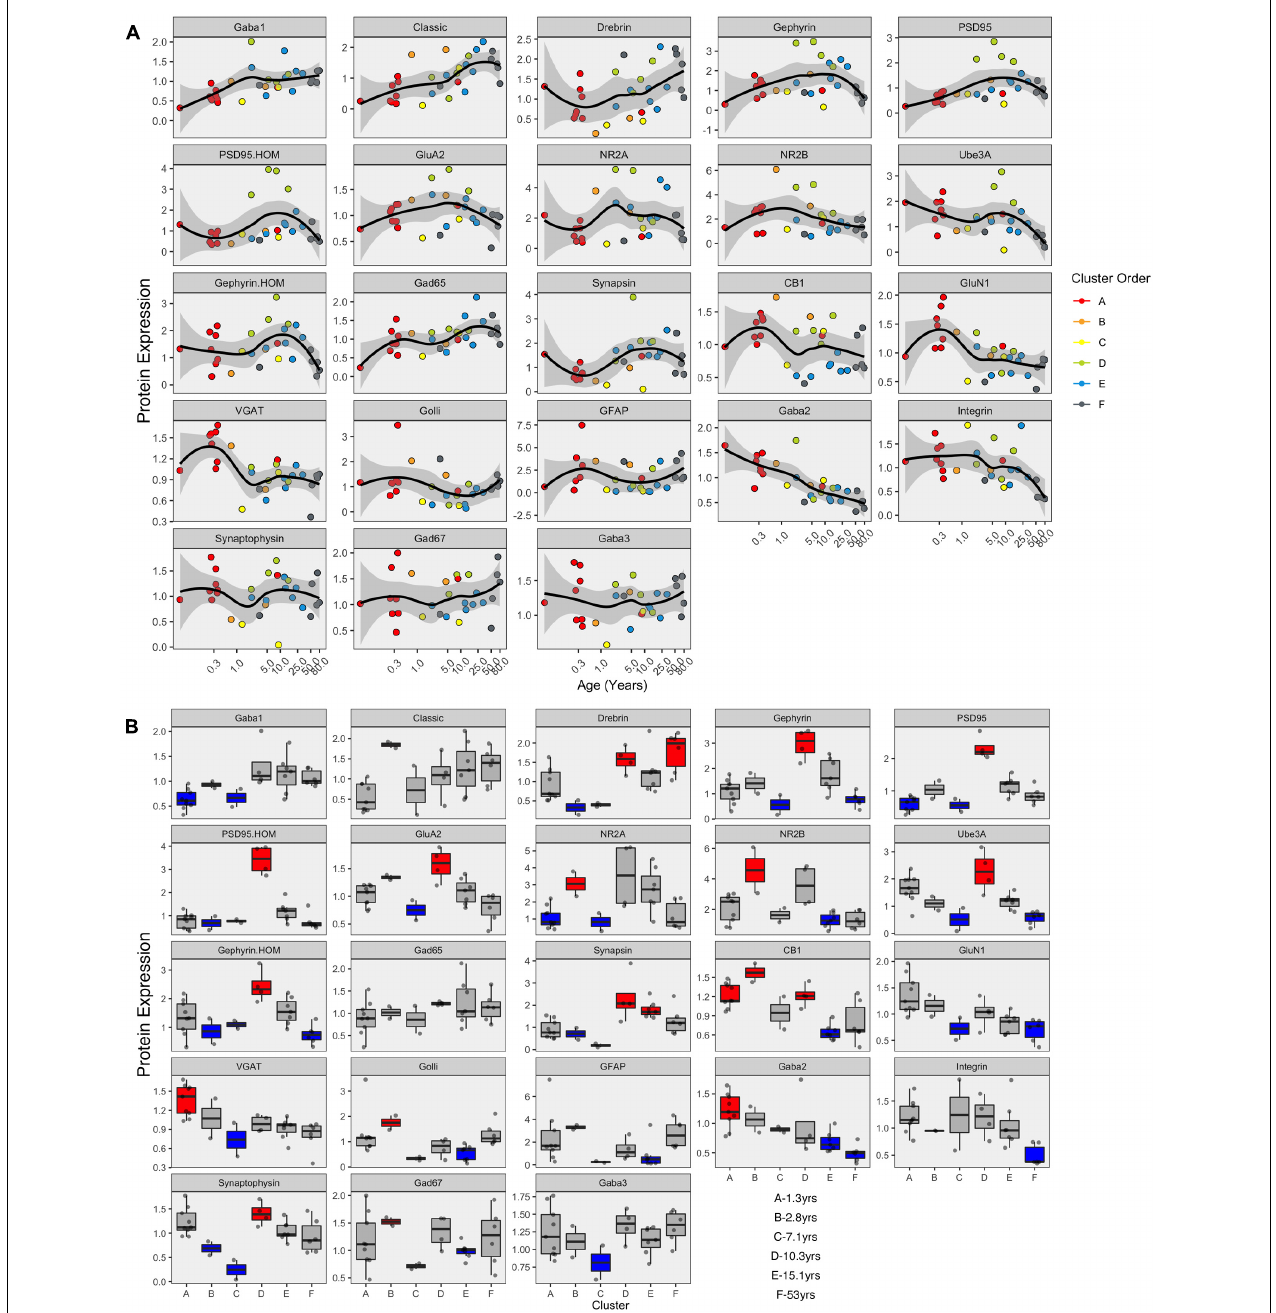
FIGURE 8 | Development of proteins by age and by cluster. Expression profiles for each of the 23 proteins (A) . Individual samples are represented by a single dot, and colored according to the corresponding RSKC cluster assignment. LOESS curves for each profile are shown in black, with 95% upper and lower confidence intervals shown bounding gray outline. Protein profiles are ordered according to similar developmental trajectories. (B) Overrepresentation analysis showing protein expression as boxplots representing each cluster. Over-represented clusters were colored red if the 25th percentile of the RSKC cluster was greater than the 95th percentile of a simulated normal distribution. Under-represented clusters were colored blue if the 75th percentile of the RSKC cluster was less than the 5th percentile of a simulated normal distribution. Boxes that fell within the middle 90% of the simulated normal distribution were left gray.